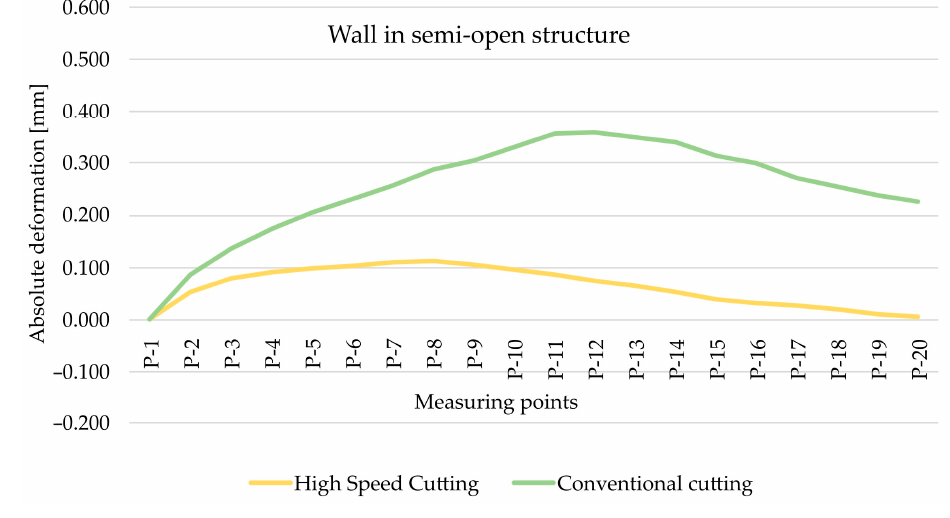
Figure 15. The comparison of absolute deformation for individual measurement points depending on the cutting type for the element with walls arranged in a semi-open structure made of the EN AW-6082 T651 aluminium alloy.